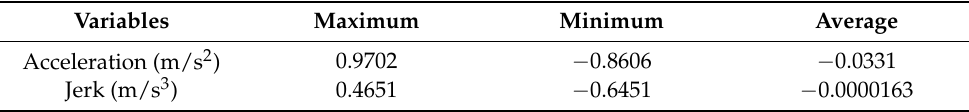
Table 1. Statistics of the acceleration and jerk of the host vehicle under driving scenario